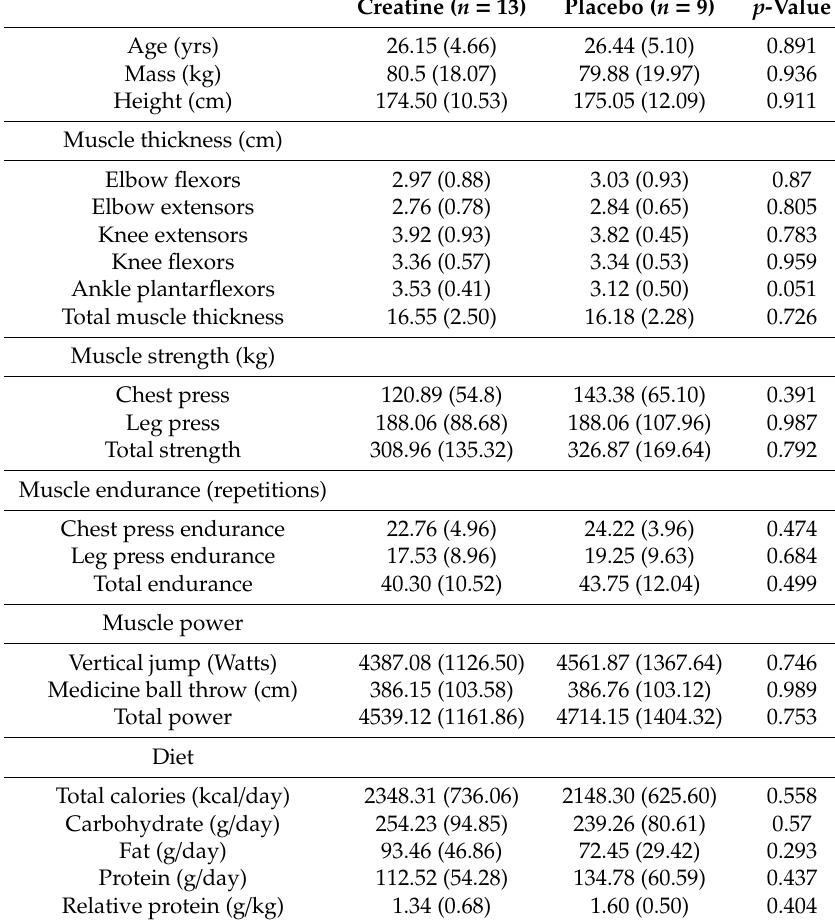
Table 1. Baseline